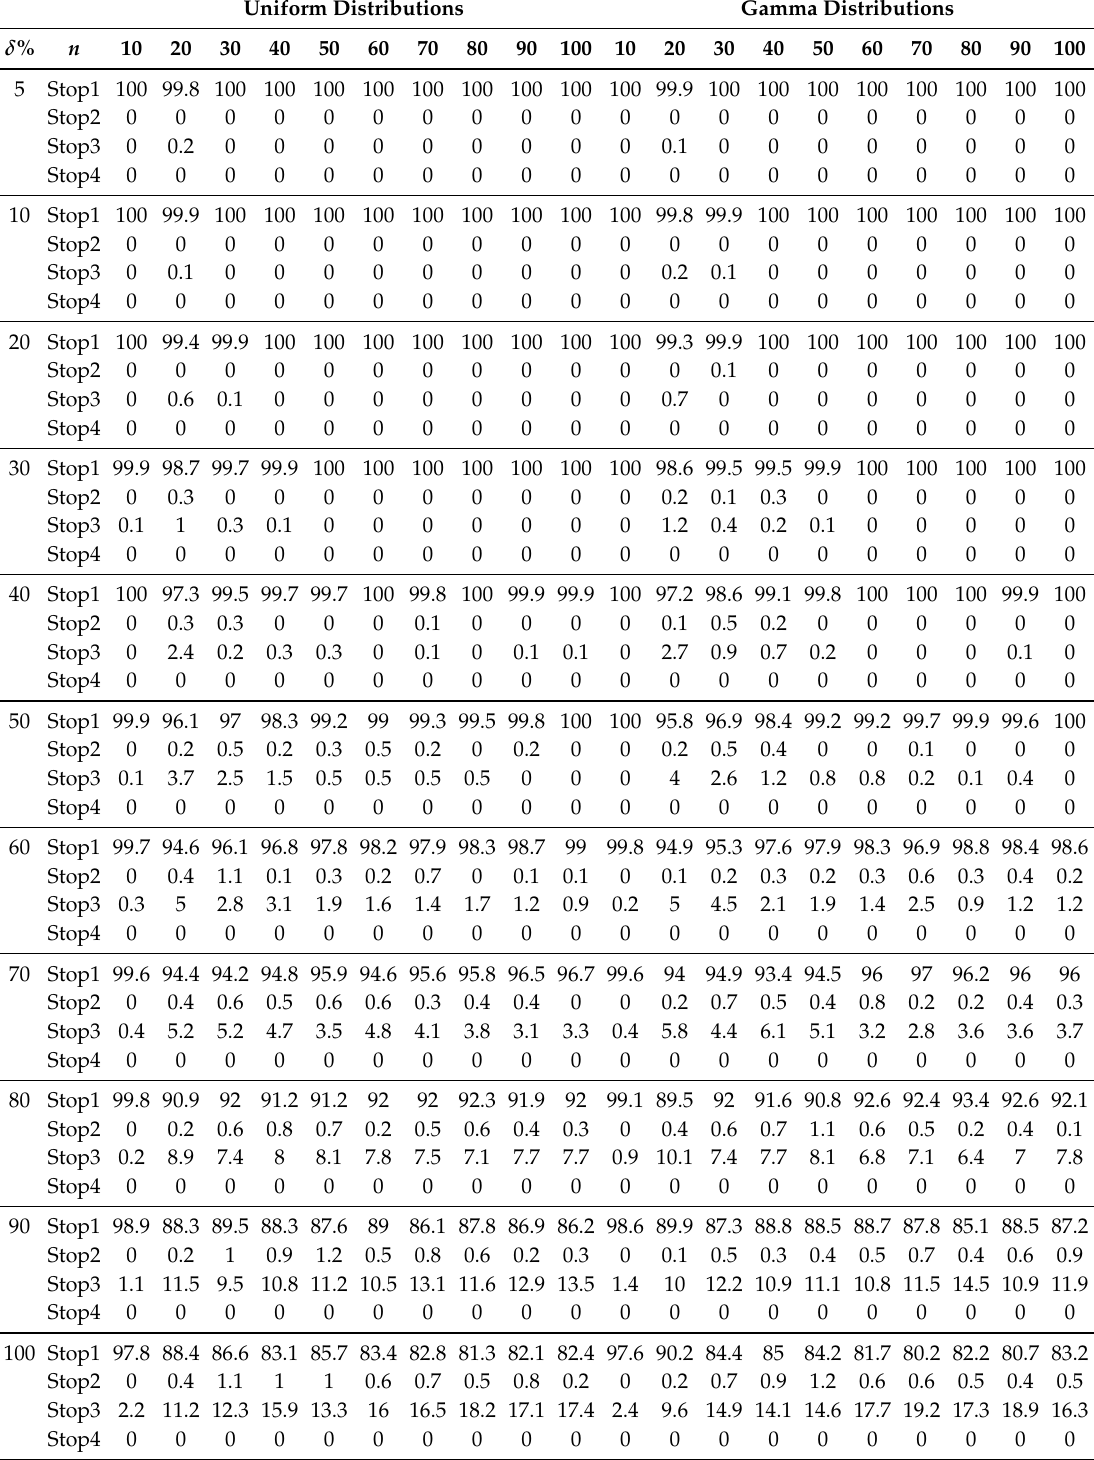
Table A14. Computational results for randomly generated instances with the ratio 10%:60%:10%:20% of the numbers of jobs in the subsets J 1 , J 2 , J 1,2 and J 2,1 of the job set J